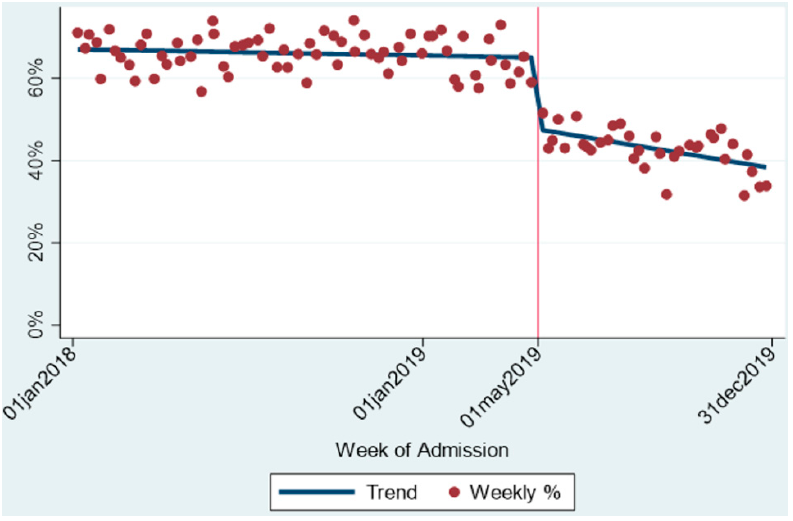
Figure 2. Opioid Exposure during Hospital Course after Cesarean Delivery.